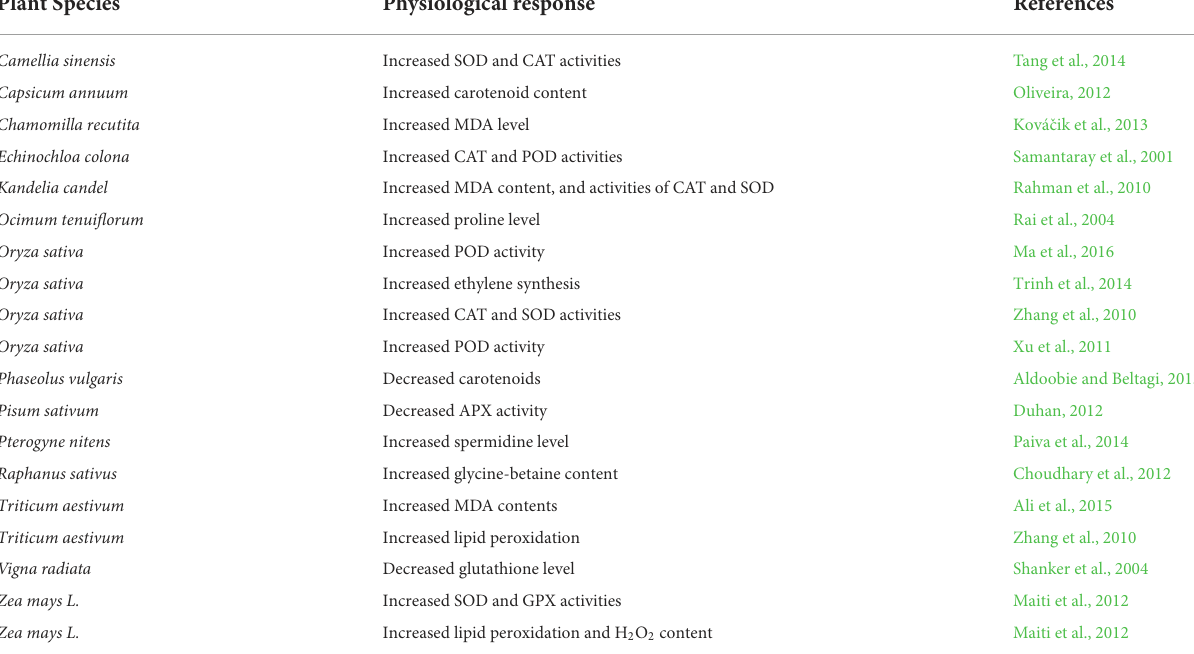
TABLE 3 Effects of chromium metal on different physiological processes in